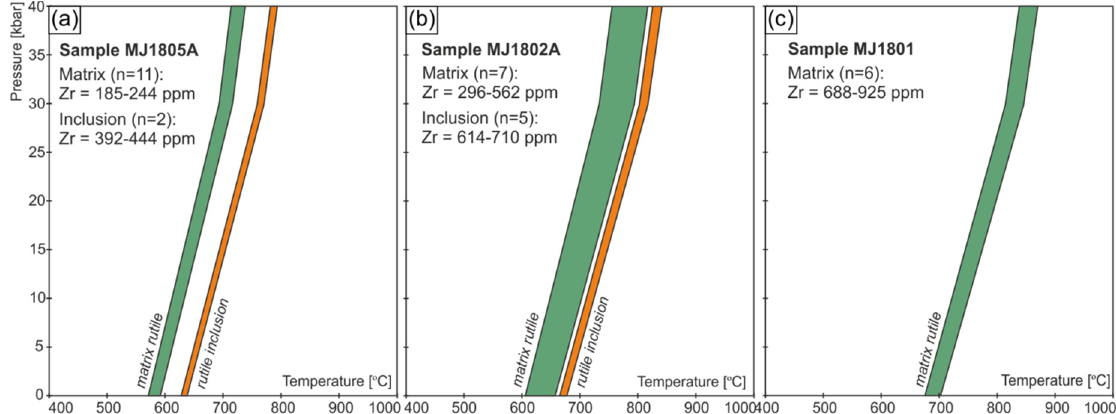
Figure 5. P-T diagrams showing the results of Zr-in-rutile geothemometry for a given textural types of rutile. Green fields show the results for matrix rutile, whereas the orange fields represent temperature range calculated for rutile inclusions. ( a ) Sample MJ1805-A: migmatitic paragneiss. ( b ) Sample MJ1802-A: migmatitic paragneiss. ( c ) Sample MJ1801: garnet amphibolite.